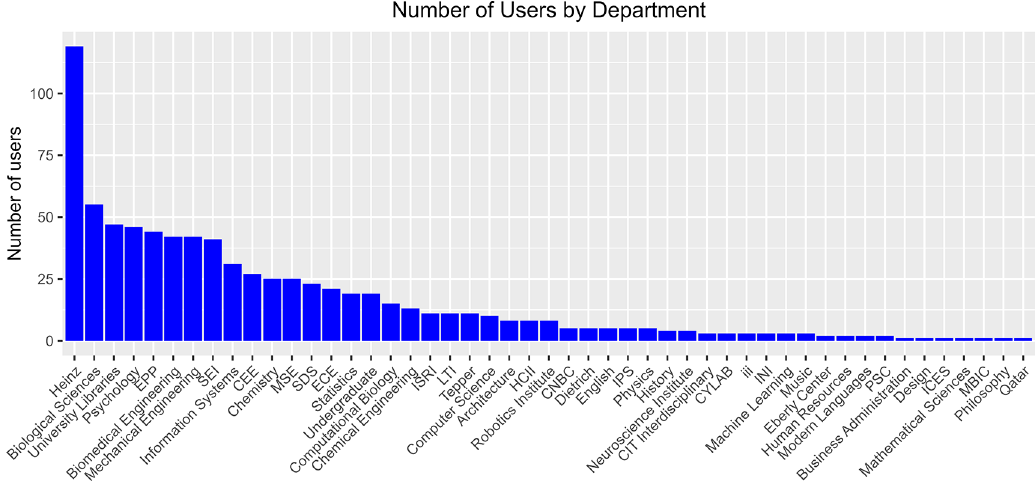
Figure3.DepartmentalbreakdownofallOSDCusers. Numberofusersbydepartmentoracademicunit,basedon their primary affiliations. The main dataset integrating all usage data was used as input. Each user is counted